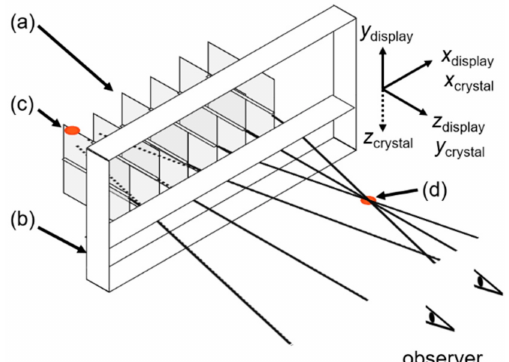
Figure 19. A solid-state leaky mode electroholographic display has an array ( a ) of LFPMs on a 2 mm pitch inside a chassis ( b ). To project a virtual (i.e., physically inaccessible) scene primitive at ( c ), the display emits diverging rays. To project a real scene primitive at ( d ), the display emits converging rays. Reproduced with permission from